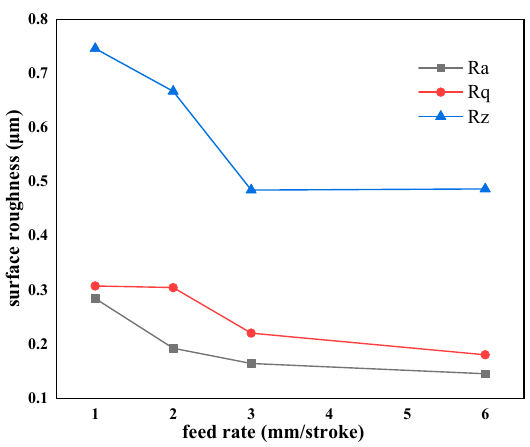
Figure 4. The evolution of surface roughness with the increase in feed rate. The normal pressure per unit area ( p c ) under different feed rates in the rolling process is given by Ю Φ Equations (4)~(8) [11]. The parameters and variables of the equation are presented in Tables 4 and 5. Figure 5 shows the curve of normal pressure per unit area plotted given different feed rates in the rolling process. It can be seen from the figure that the normal pressure per unit area increases rapidly in the case of forwarding rolling stroke, and that the normal pressure per unit area changes as the feed rate varies from 1 mm/stroke to 6 mm/stroke. The higher the feed rate, the greater the normal pressure per unit area. When the feed rate rises, the volume of metal compressed in a single pass